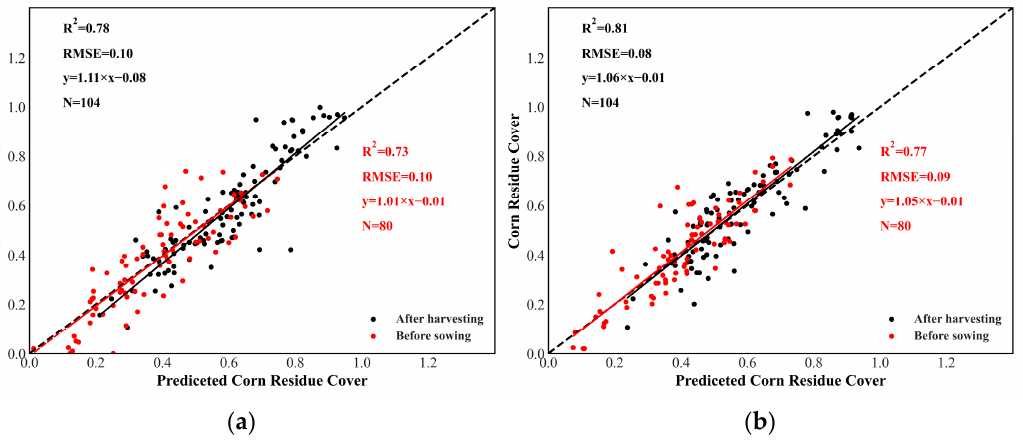
Figure 9. Estimated result of CRC by multiple linear regression ( a ) and random forest ( b ).